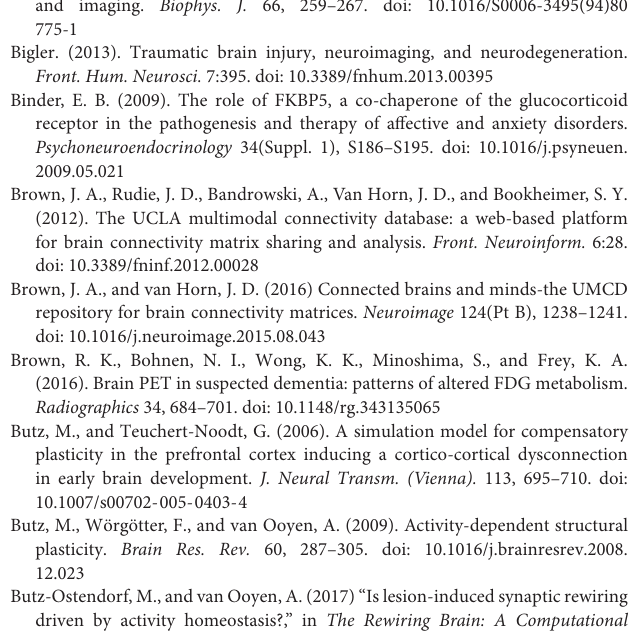
and thereby connects the workflow to the patient data. FSL processing tools are indicated by rectangular objects with rounded corners; a rhombus indicates a linear transformation while a flag shape indicates a non-linear transformation. Colors are used to group different objects. Reddish colors indicate objects that hold image data in original coordinate space, while yellow indicates objects in MNI 152 coordinate space. Bluish colors were used for FSL calls and gray for transformations. Colors and shapes following Alfaro-Almagro et al. (2018). TABLE S1 | Mappings between different brain atlases. We manually created mappings for the 127 brain areas of the Craddock200 to other brain atlases and ontologies including PowerNeuron264, Human Allen Brain Atlas, FMA, FreeSurfer and Brede WOROI ontology. TABLE S2 | Functional brain network (FBN) of the limbic lobe. A query revealed 110 connections between brain areas that belong to the limbic lobe according to Allen Human Brain Atlas ontology classification which have associated DTI and resting state fMRI measurements from the NKI Rockland study. TABLE S3 | High gene expression of fkbp5. 211 measurements indicate the localized binding of probes to the fkbp5 gene in the brain. Only expression values greater than 8 and signals significantly greater than background noise (PACall value equal to 1) are listed. TABLE S4 | High gene expression of gmeb1. 79 measurements indicate the localized binding of probes to the gmeb1 gene in the brain. Only expression values greater than 8 and signals significantly greater than background noise (PACall value equal to 1) are listed. TABLE S5 | High gene expression of gmeb2. 11 measurements indicate the localized binding of probes to the gmeb2 gene in the brain. Only expression values greater than 8 and signals significantly greater than background noise (PACall value equal to 1) are listed. TABLE S6 | Brain area with high gene expression for fkbp5, gmeb1, gmeb2. The hippocampal CA4 region is the only area in which fkbp5, gmeb1 and gmeb2 is significantly highly expressed (expression value > = 8). TABLE S7 | Brain connectivity and transcription networks. A query revealed 9751 combinations of brain areas in which measurements of structural (DTI), functional connectivity (fMRI) and differential expression of genes (DEG) are